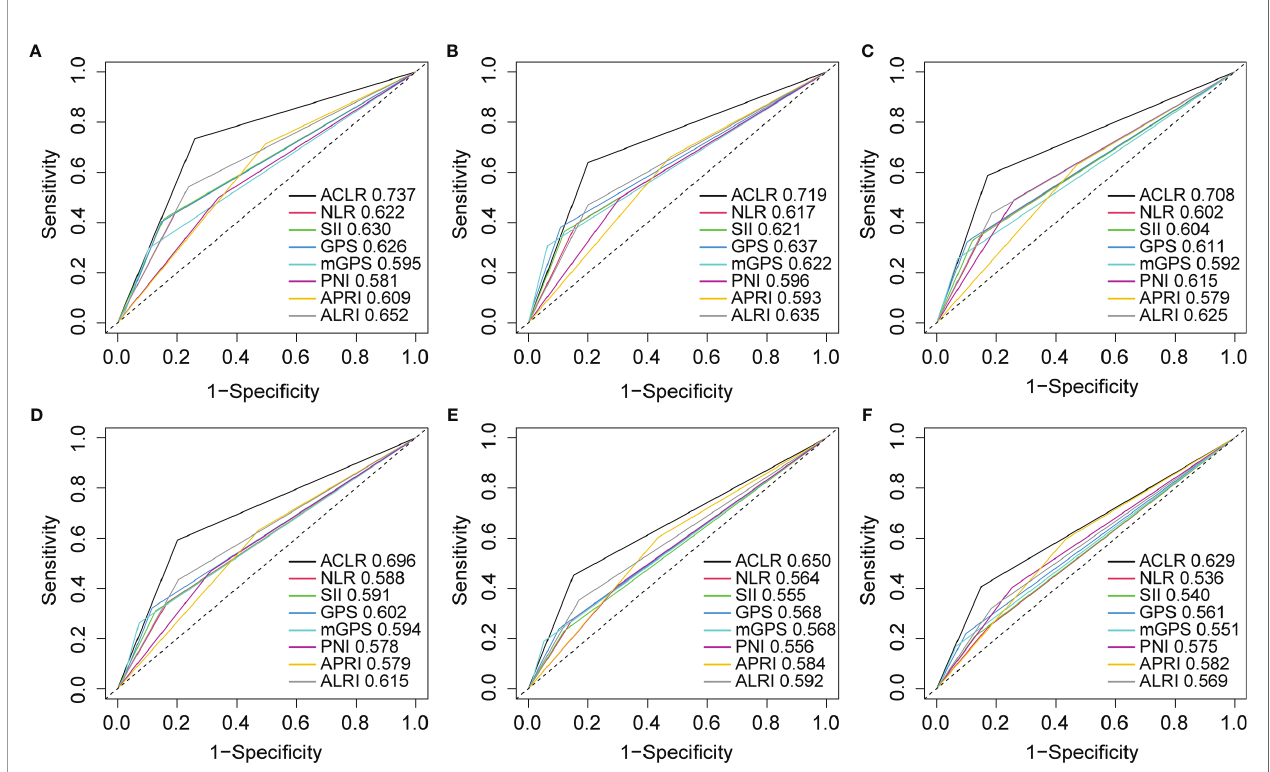
FIGURE 3 | Receiver operating characteristic (ROC) curves analysis to compare the predictive value of ACLR with other in fl ammation-immune models. (A – C) ROC curves of ACLR and other in fl ammation-immune models for (A) 1-, (B) 3-, and (C) 5-year OS in the whole cohort. (D – F) ROC curves of ACLR and other in fl ammation-immune models for (D) 1-, (E) 3-, and (F) 5-year TTR in the whole